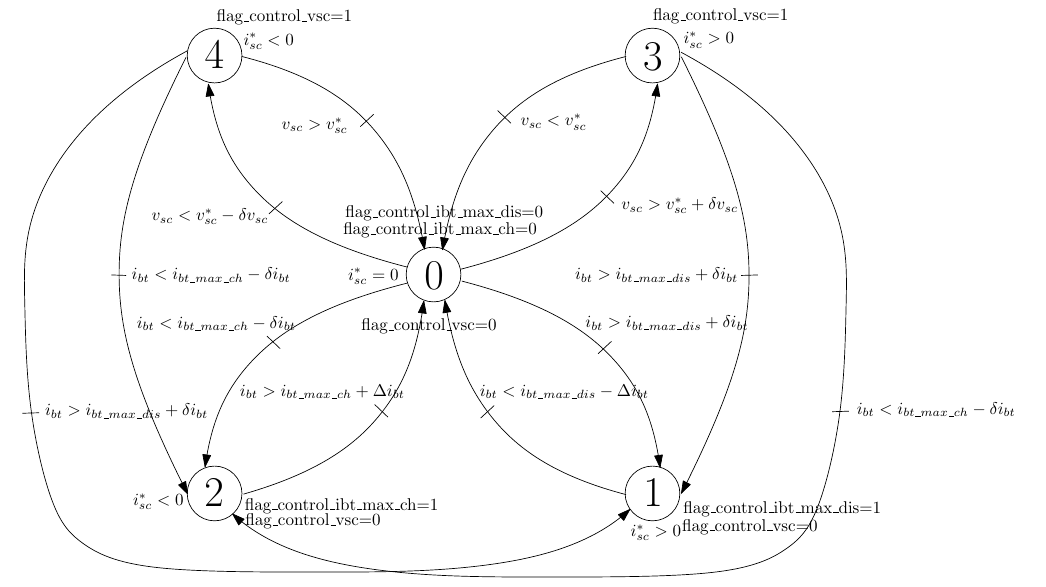
Figure 6. State machine of the